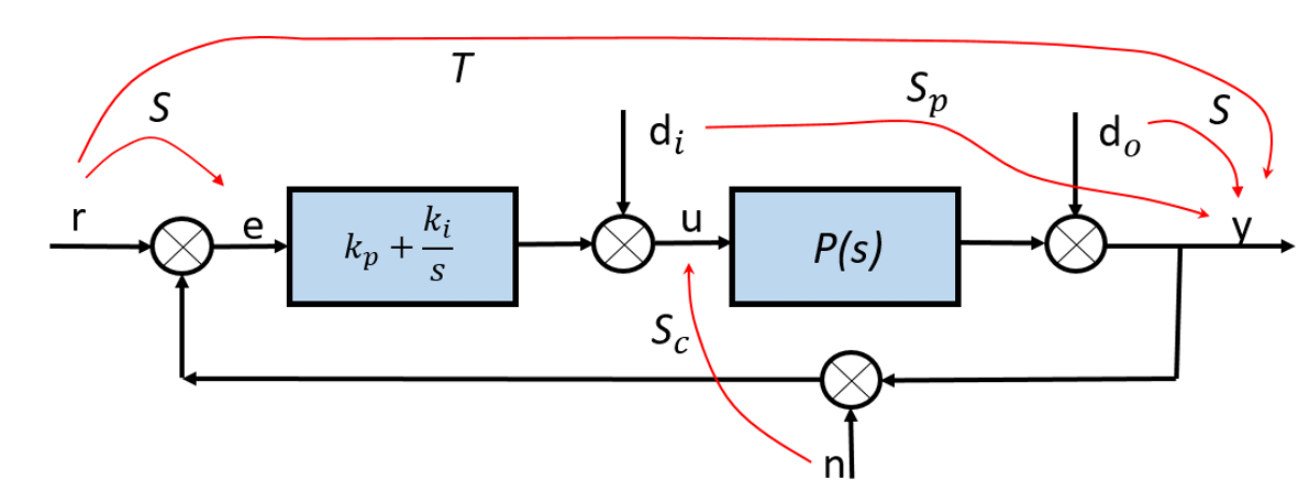
Figure 7. Assumed control setup: P ( s ) : model of the controlled plant, k p , k i : parameters of the fixed-structure PI controller, S , T , S p , S c : closed-loop sensitivity functions, r : setpoint reference, e : tracking error, u : manipulated variable, y : controlled output.